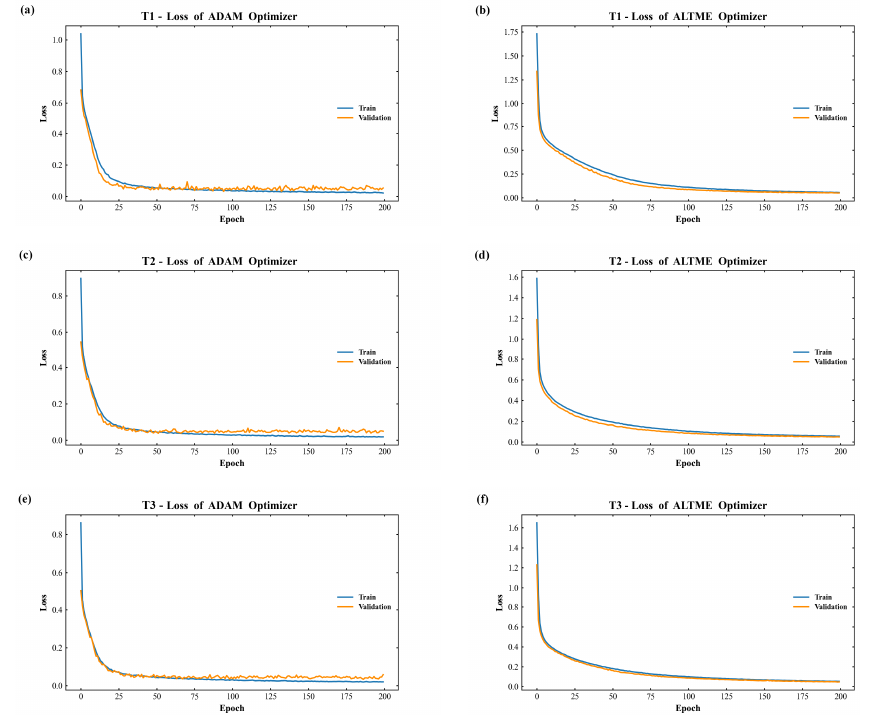
Figure 16. Comparison of the loss values of the ALTME and Adam optimizer. ( a , c , e ) are loss values of the Adam optimizer at T1–T3, respectively. ( b , d , f ) are loss values of the ALTME optimizer at T1–T3, respectively.